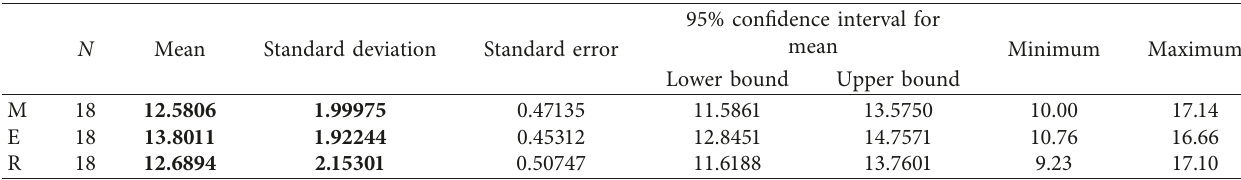
Table 4: Descriptive statistics for the learners’ scores in the pretest.